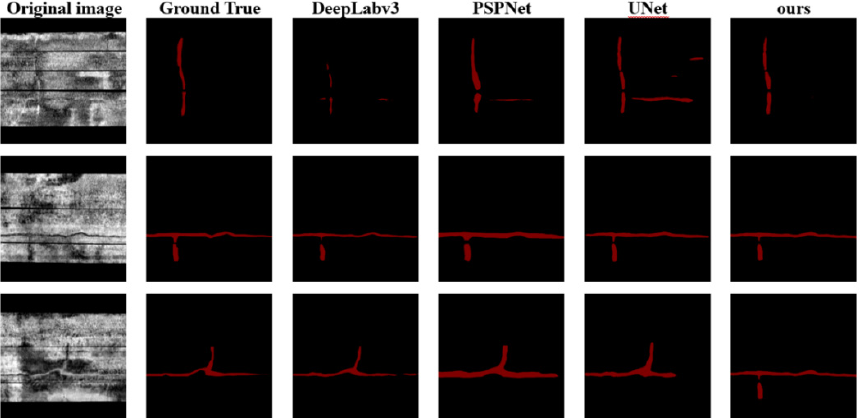
Figure 14. Comparison of segmentation diagrams among models in crack test set.